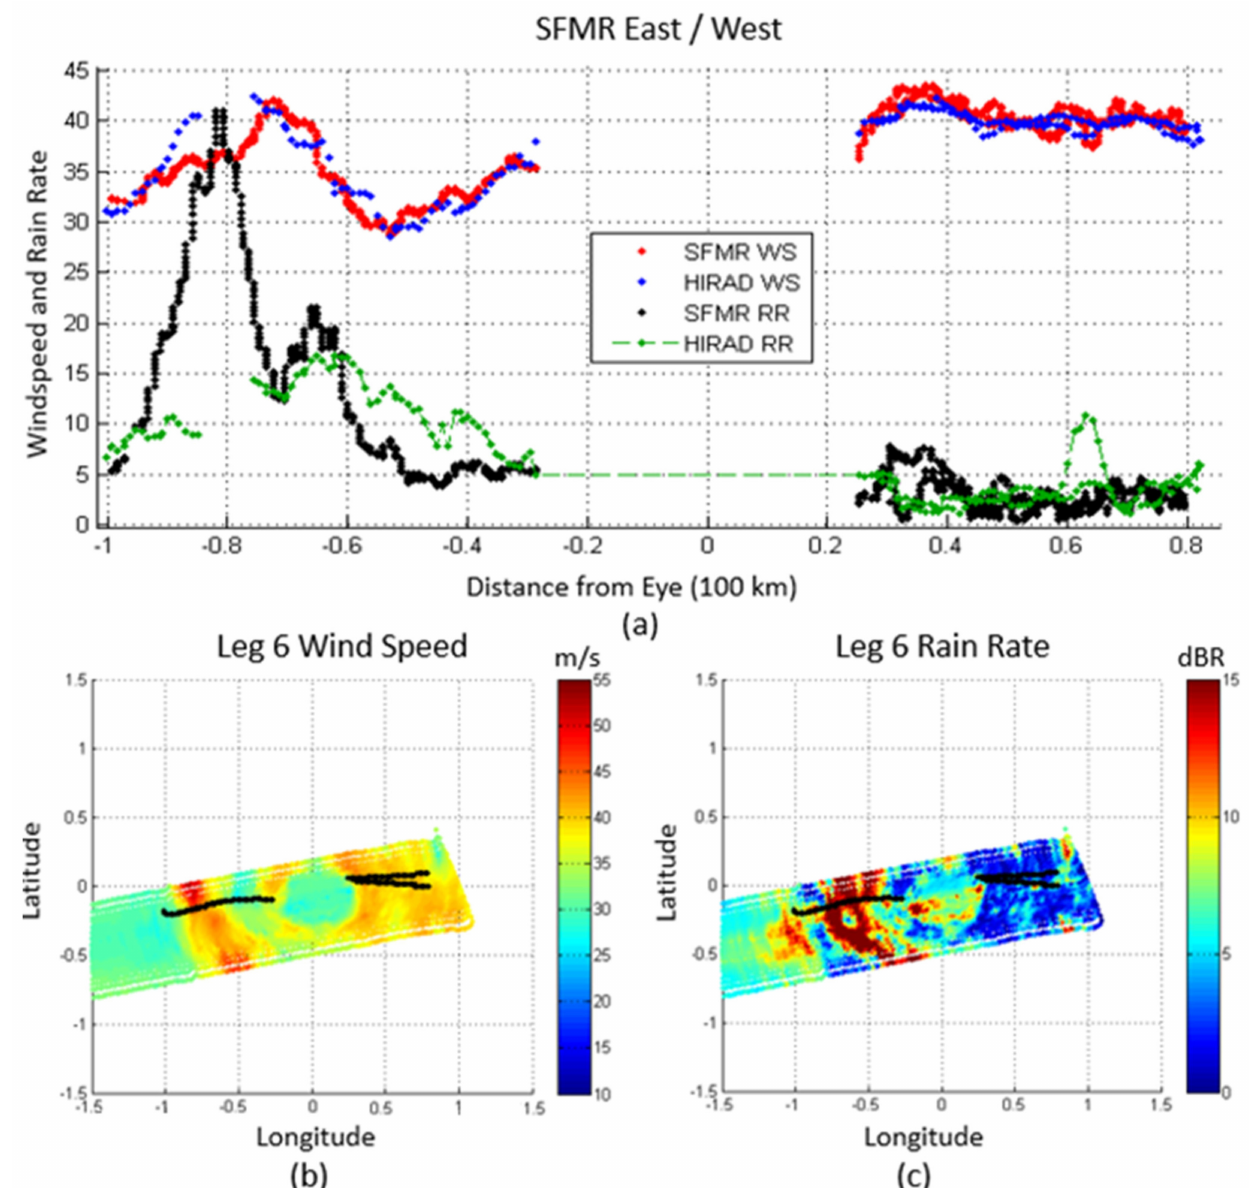
Figure 15. HIRAD to SFMR geophysical retrieval comparisons for Hurricane Gonzalo Leg 6, where in ( a ) SFMR/HIRAD results are WS (blue/red) and RR (green/black), respectively. The lower panels ( b , c ) show the HIRAD WS and RR measurements, with the SFMR measurement location in